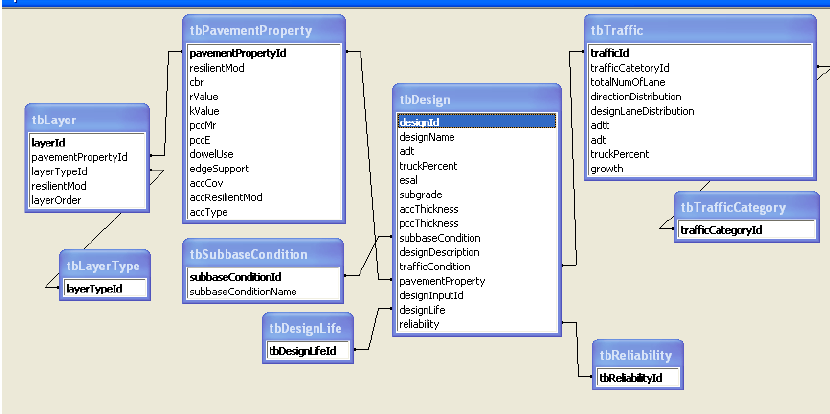
Figure 4. Database structure and relationship in Microsoft Access database.